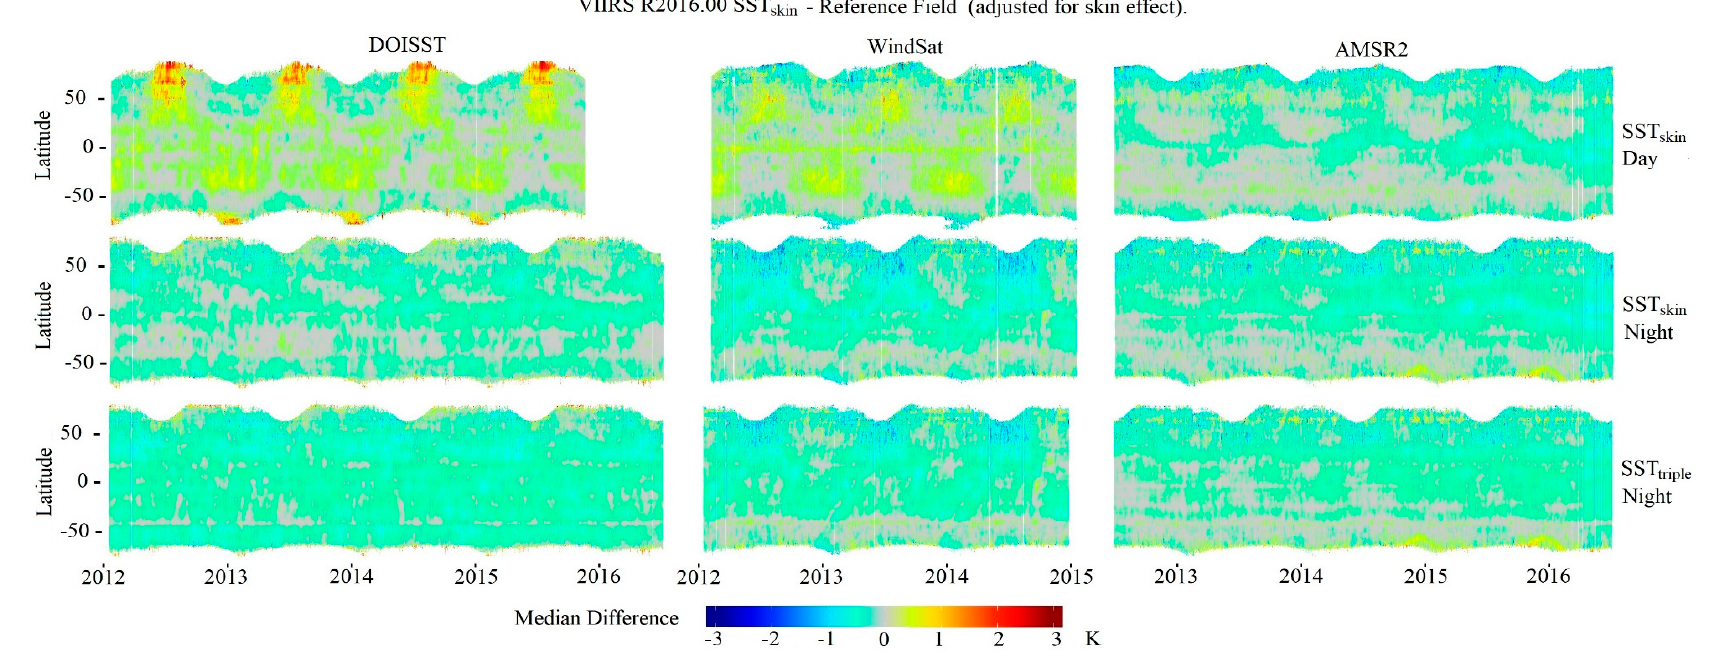
Figure 10. Hovmöller plots of the zonal median difference between 9 km daily Level 3 products of VIIRS R2016.0 SST skin , day and night separately, and SST triple and three independent fields. Top Row: Day time SST skin derived using Equation (3), Middle Row: Night time SST skin derived using Equation (3). Bottom row: night time SST skin derived using the triple window algorithm (SST triple ; Equation (4)) Left panels: DOISST; center panels: microwave SSTs from WindSat; right panels: microwave SSTs from AMSR2. The horizontal axis shows time. The grey color indicates differences < 0.05 K.